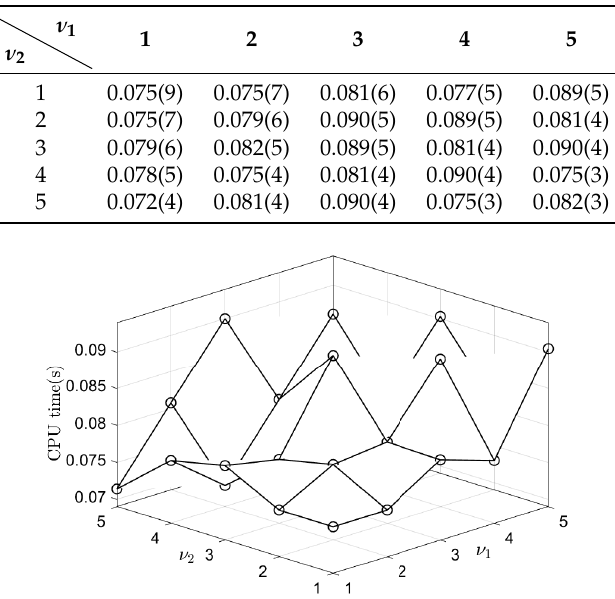
Figure 8. Average CPU time for different pre- and post-relaxation numbers after 100 time